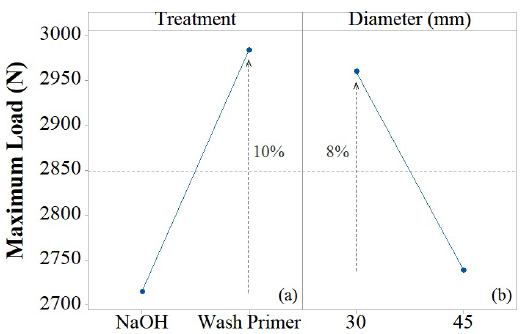
Figure 6. Main effect plots for the mean maximum